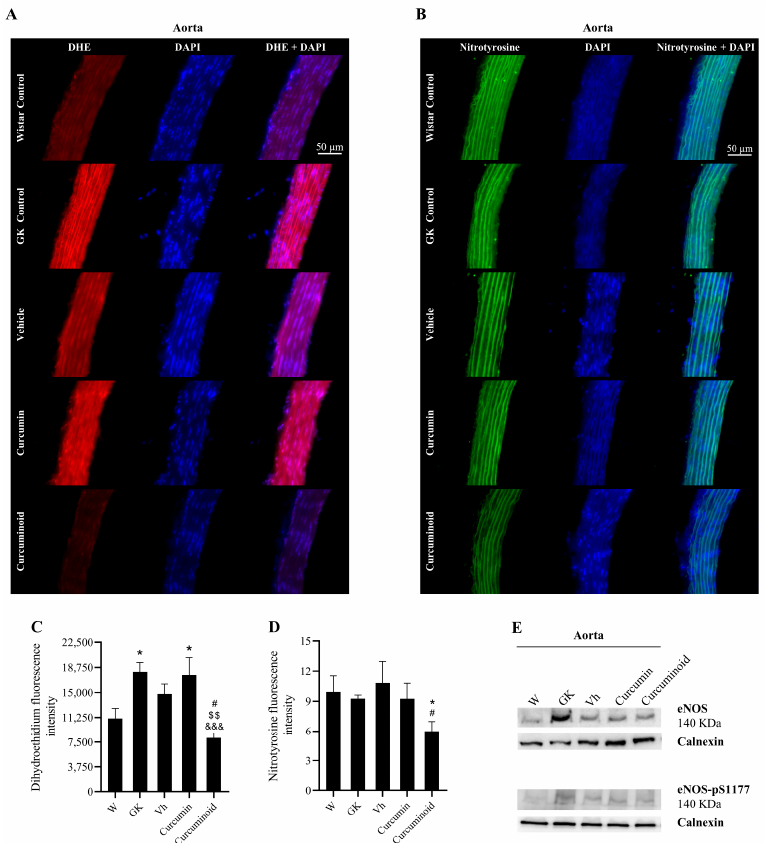
Figure 4. The curcuminoid improved the oxidative and nitrosative stress. Oxidative stress was evalu- ated though the determination of superoxide generation by the DHE dye. ( A ) Shows representative DHE staining (red) in aortic sections and ( C ) shows quantification of the DAPI (blue)-normalised red fluorescence. Nitrosative stress was evaluated using an anti-nitrotyrosine antibody. Representative aortic sections of nitrotyrosine staining (green) ( B ) quantification of the green fluorescence (DAPI normalised) ( D ). Total and phosphorylated eNOS were assessed by WB; representative WB are shown ( E ); W: Wistar control; GK: Goto-Kakizaki control; Vh: Goto-Kakizaki submitted to vehicle (DMSO) administration; Curcumin: Goto-Kakizaki submitted to curcumin administration (40 mg/Kg/day, s.c.) and Curcuminoid: Goto-Kakizaki submitted to curcuminoid (52.4 mg/Kg/day, s.c.) administra- tion. Results are expressed as mean ± S.E.M.; vertical bars represent S.E.M.; n = 5–9/group; statistical differences were evaluated by Tukey’s test. * vs. W; & vs. GK; # vs. Vh; $ vs. Curcumin. 1 symbol p < 0.05; 2 symbol p < 0.01; 3 symbol p <